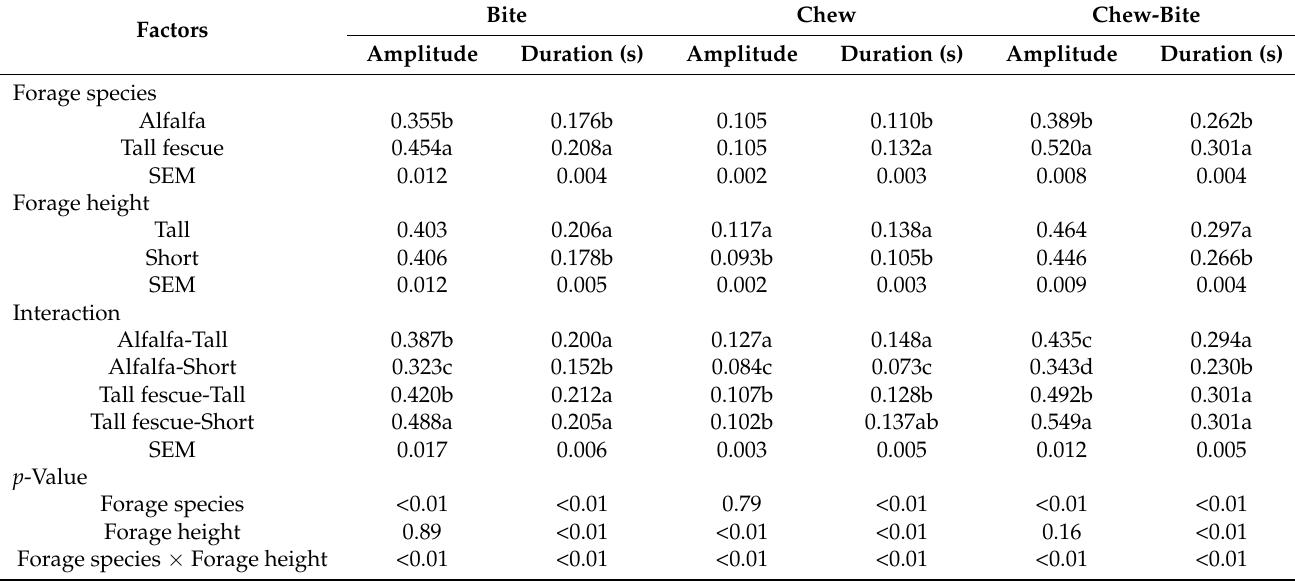
Table 2. Amplitude and duration of the bite, chew, and chew-bite sound under various forage